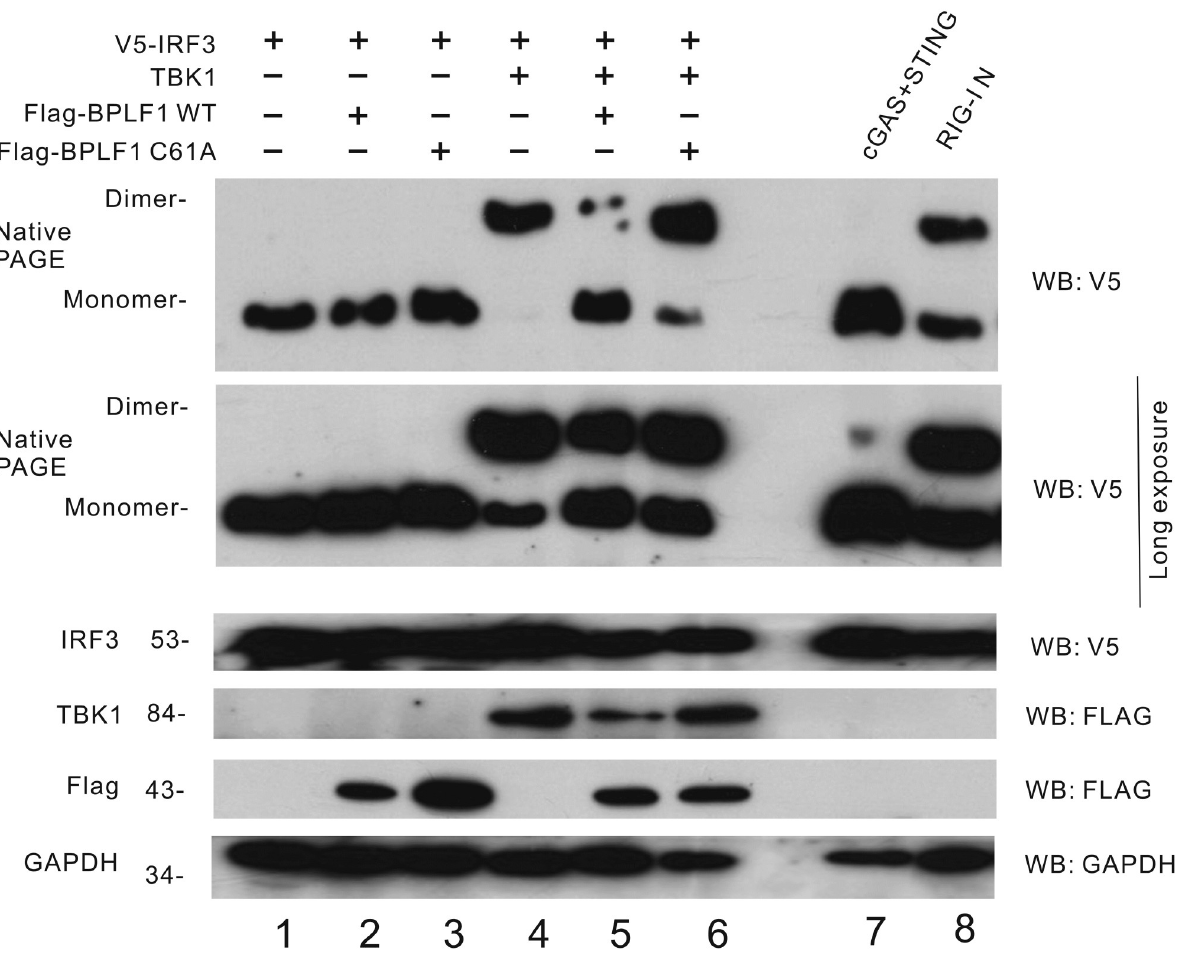
Fig 7. BPLF1 mitigates TBK1-induced dimerization of IRF3. IRF3 dimerization assay by native PAGE. BPLF1 and mutant C61A were transiently overexpressed in HEK293 cells together with TBK1 and V5-IRF3. Cells were harvested 48 hours after transfection. The cell lysates were subjected to SDS-PAGE and native PAGE. The lysates were analyzed by Western blotting by anti-V5, anti-Flag, anti-TBK1 and anti- α -tubulin antibodies.